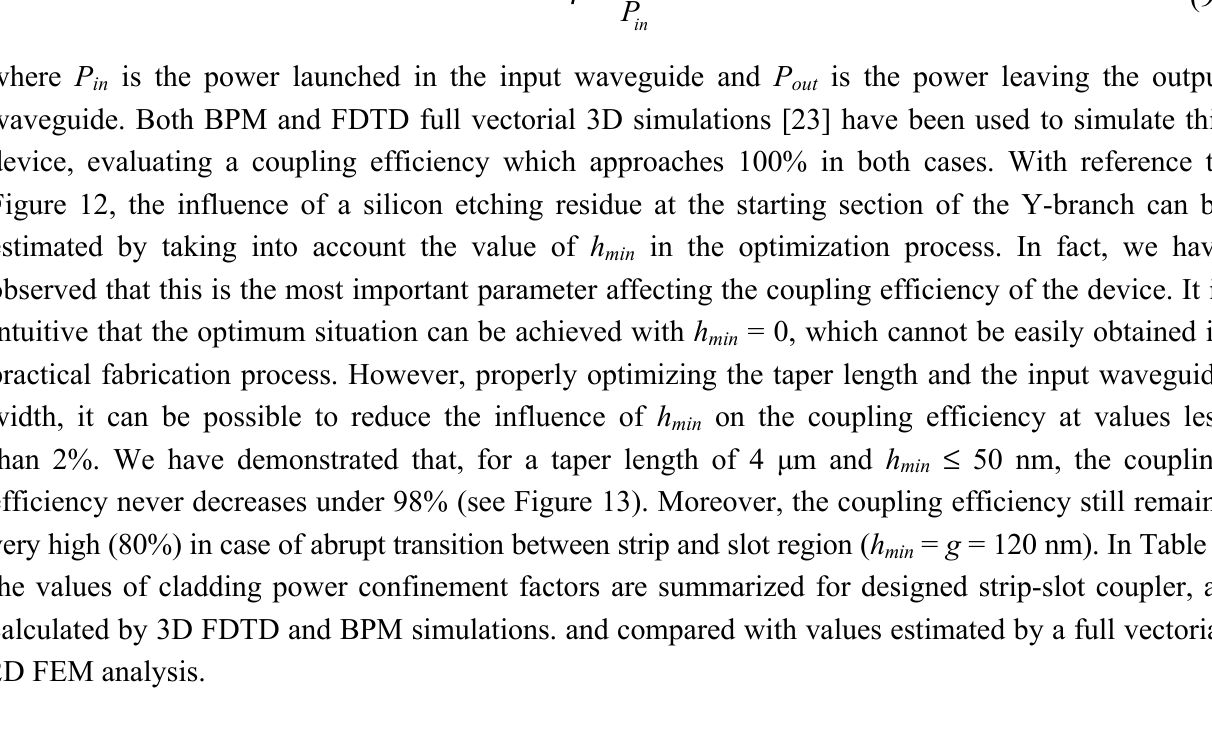
for the proposed strip-slot-strip coupler (in the min